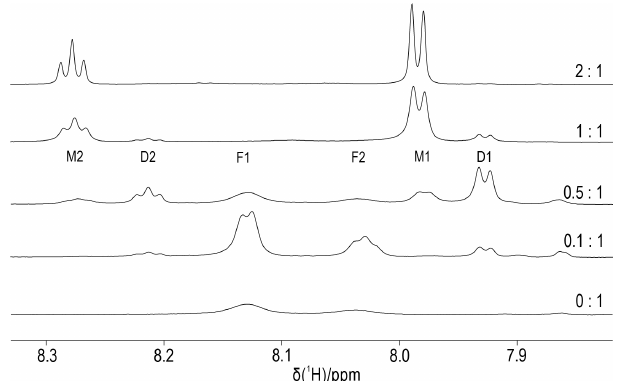
Figure 6. Titration of DCP-( L -Cys) 2 with YCl 3 . The molar ratios of Y 3 + ions to DCP tag are indicated on the right. The spectra were recorded of a 0.3mM sample of DCP-( L -Cys) 2 in D 2 O contain- ing 10mM HEPES buffer (pH7) at 25 ◦ C, using an 800MHz NMR spectrometer. The spectral region shown contains the signals of the pyridyl ring, which comprise a doublet and a triplet of intensity ra- tio 2 : 1. We assign the peaks F1 and F2 to unbound DCP-( L -Cys) 2 , M1 and M2 to the 1 : 1 complex with Y 3 + ion, and D1 and D2 to the complex of two DCP-( L -Cys) 2 molecules sharing a single Y 3 +